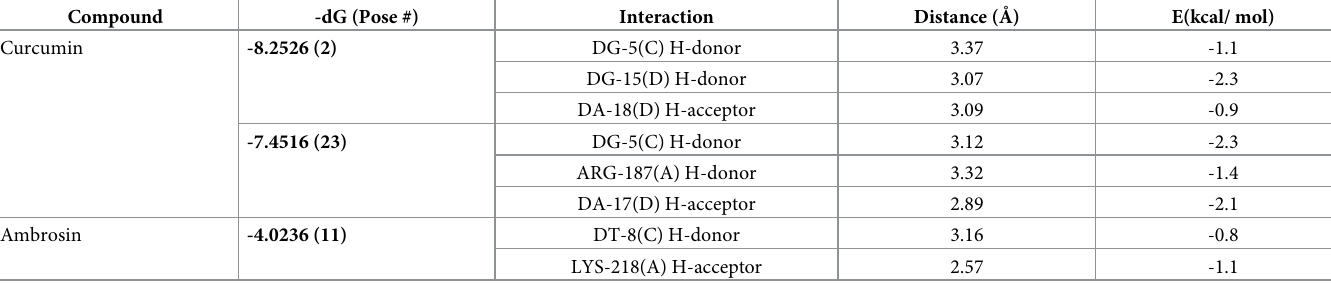
Table 5. Docking Scores and interaction modes of Curcumin and Ambrosin with NF- κβ p65 (PDB ID: 1VKX). Compound -dG (Pose #) Interaction